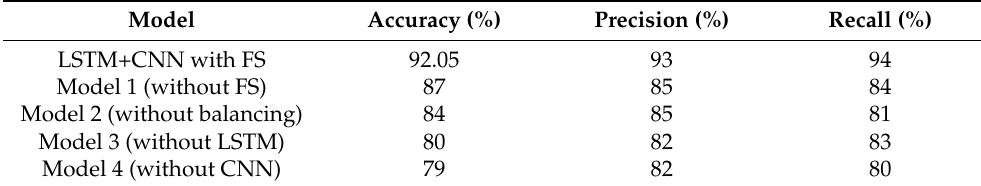
Table 13. Performance evaluation of LSTM+CNN model in ablation